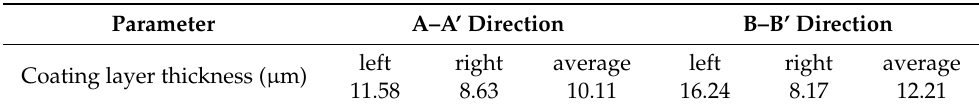
Table 1. The calculated coating thickness.